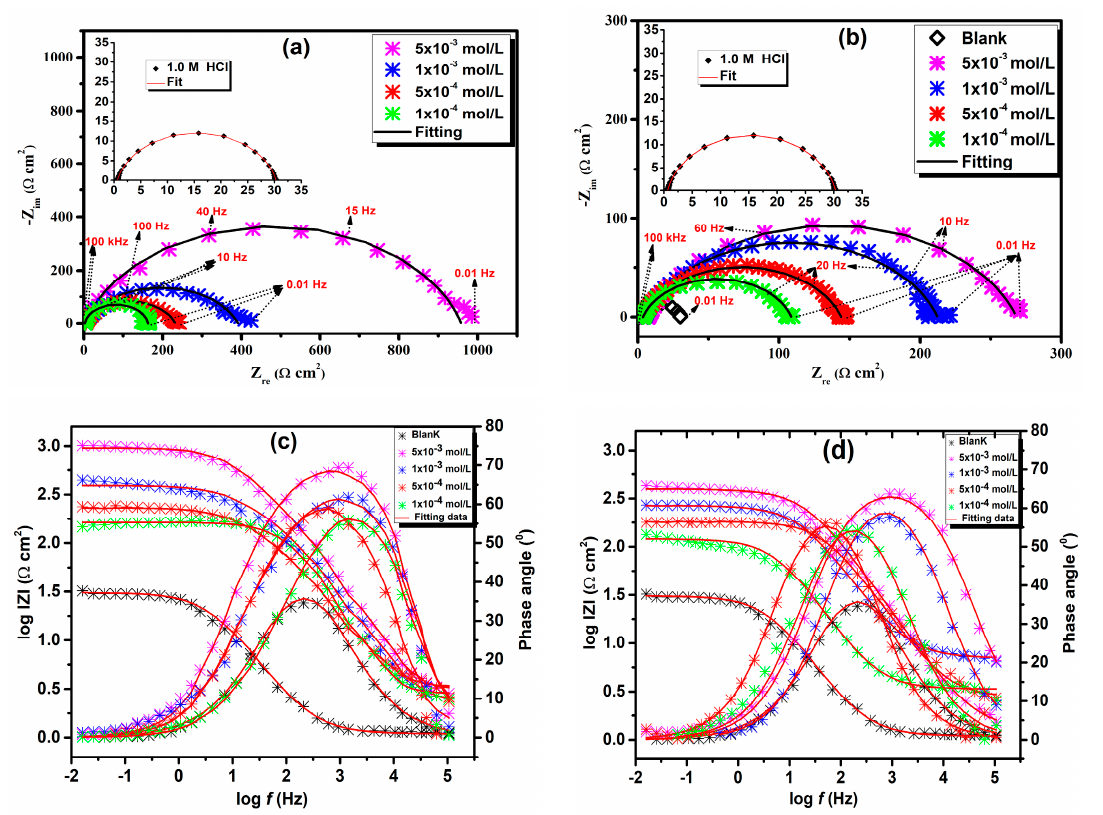
Figure 4. Nyquist and Bode plots for mild steel corrosion in 1.0 M HCl without and with different inhibitors concentrations of Q1 and Q2, ( a ) Nyquist plots of Q1, ( b ) Nyquist plots of Q2, ( c ) Bode plots of Q1, ( d ) Bode plots of Q2.